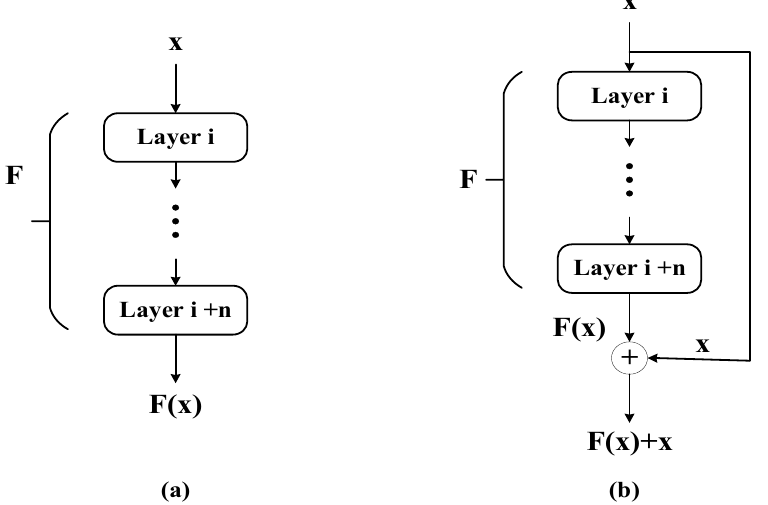
Figure 10. ( a ) Feedforward without the residual connection. ( b ) Feedforward with the residual connection. Residual Connection is a kind of skip-connection that learns residual functions with respect to the layer inputs rather than learn unreferenced functions.